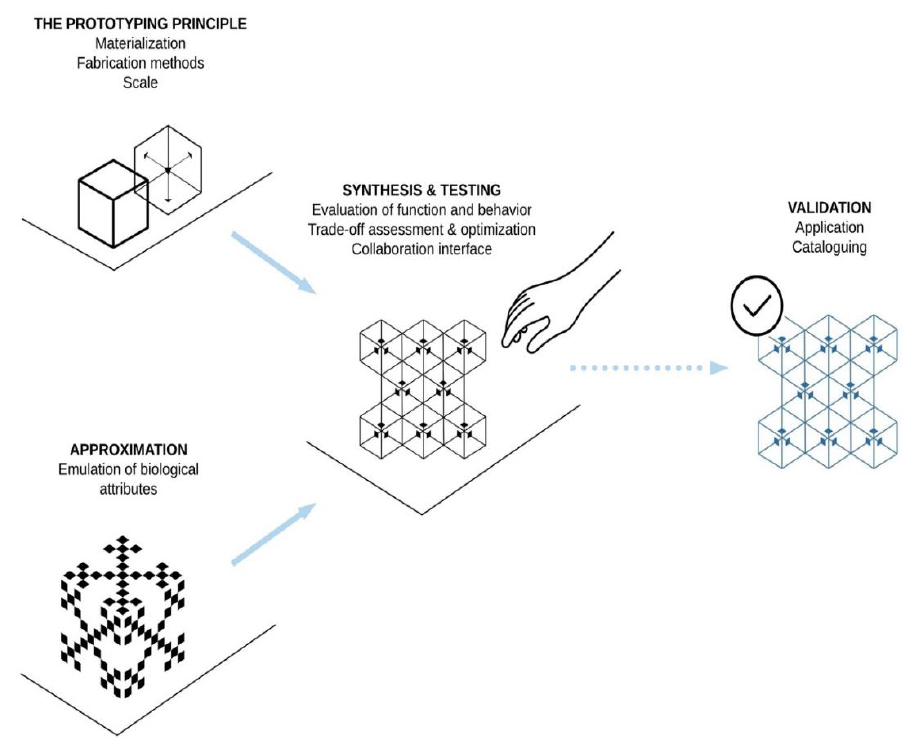
Figure 9. Key activities for the ‘ performance-based abstraction ’ of biomimicry design principles.